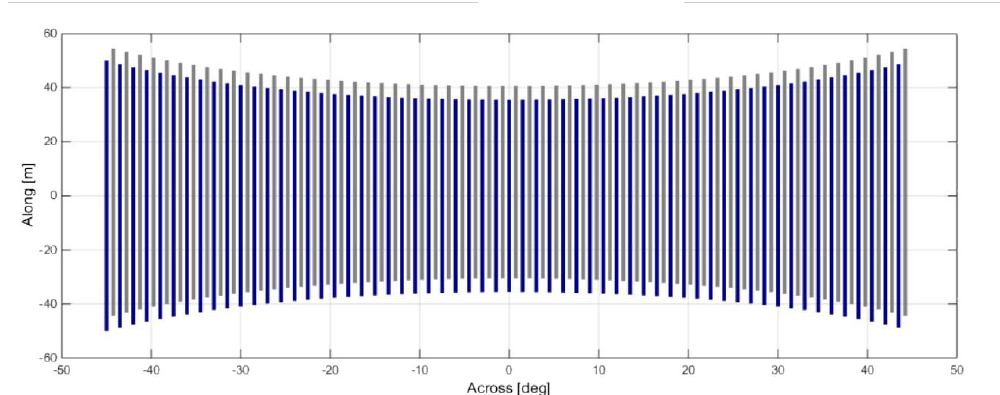
Figure 25. TX footprint for two swaths (Dual swath mode) at 2000 m